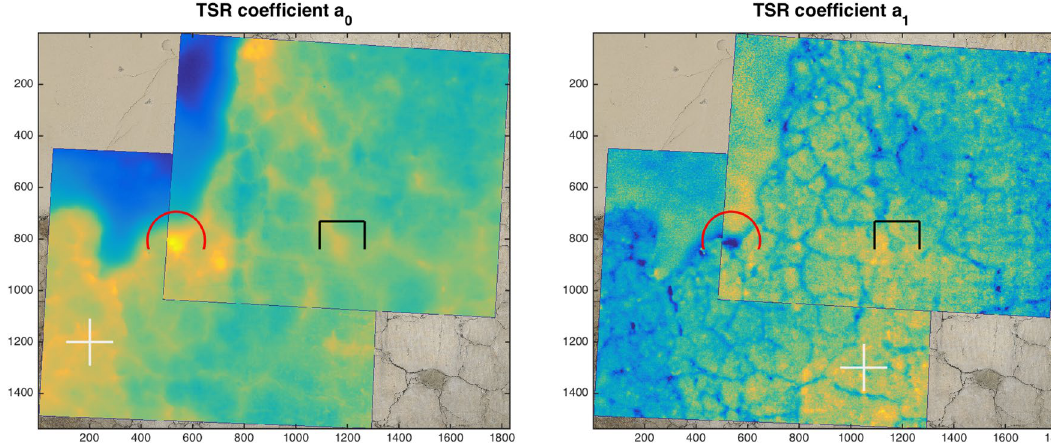
Figure 6. Mosaic of the TSR coefficient maps a 0 and a 1 registered to the orthophoto for two selected frames. Red marker indicates a significant detachment, black marker an old stucco filling. The sub-millimeter resolution allows the precise mapping of the serious network of cracks through the a 1 coefficient. White marker indicates areas of anomalous thermal signature due to the different surface emissivity and heat absorption, which is effectively mapped by the first polynomial coefficient. Emissivity map can be inspected looking at the complementary TQR reflective signal (see Fig.